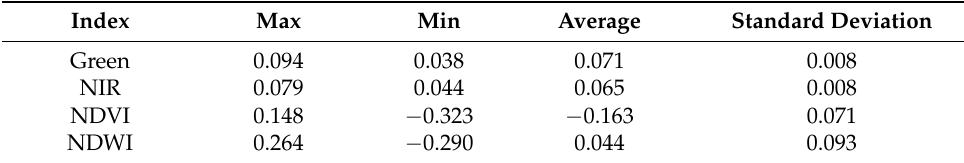
Table 2. Spectral sample data description ( n = 171).